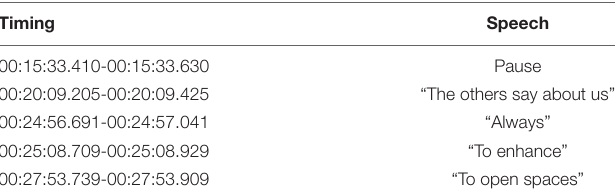
TABLE 1 | Recurrence of AU4 emphasis expression and corresponding speech. Timing